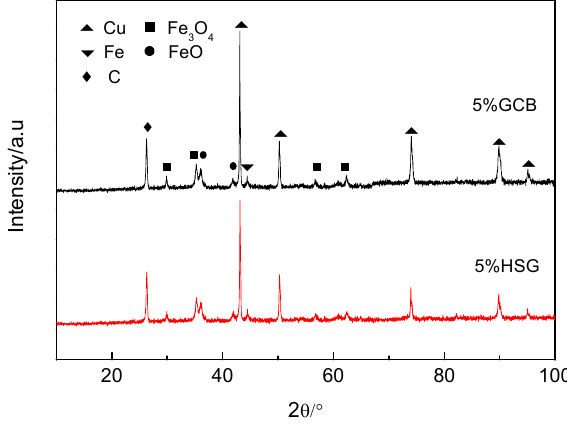
Figure 6. X-ray Diffraction (XRD) patterns of worn surfaces with different lubricating phases.